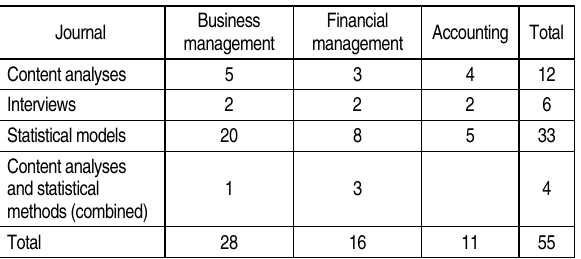
Table 2. Research methods used by the topic